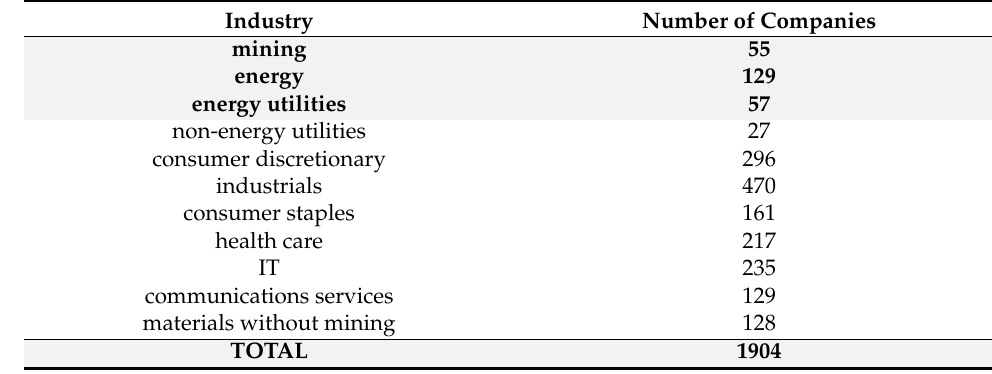
Table 1. Assessed groups of